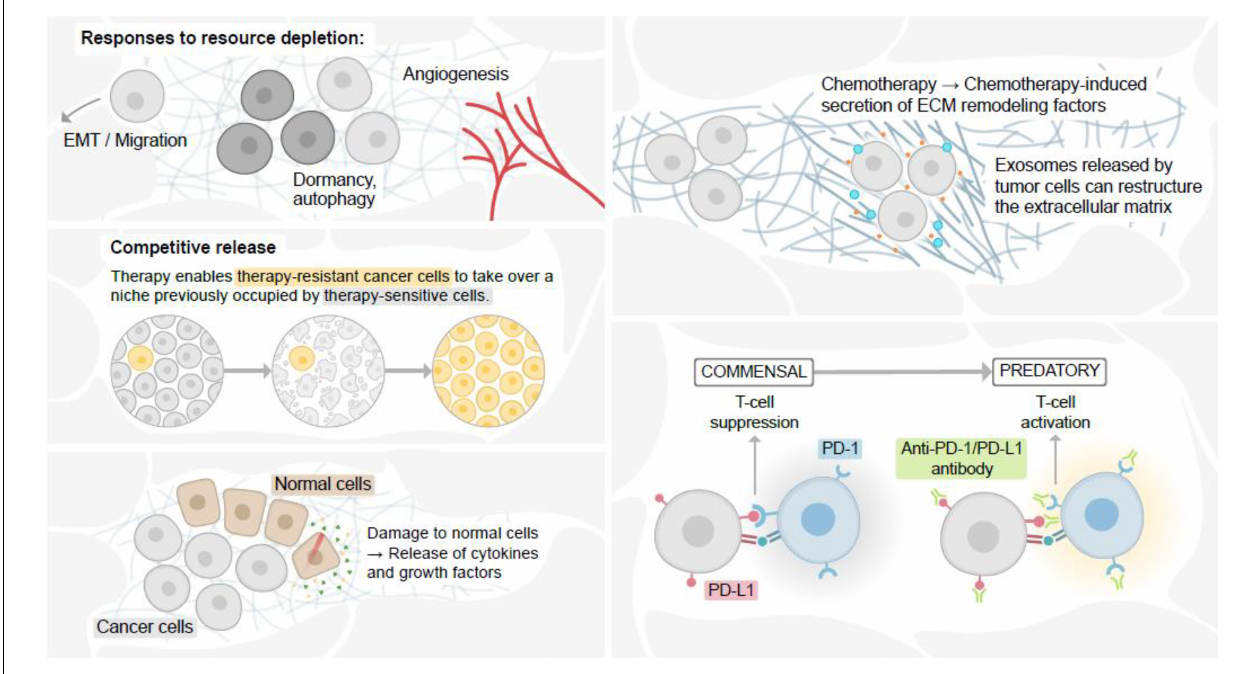
FIGURE 3 | Therapy alters the cancer cell ecological niche. Cellular responses to resource depletion in the face of therapy can induce epithelial-mesenchymal transition (EMT) and migration, altered resource acquisition, and angiogenesis (upper L) . Therapy-induced cellular damage can promote continued growth and tissue remodeling, providing growth factors and tissue space for remaining cancer cells to reoccupy the altered niche (bottom L) . Removal of drug-sensitive cells from an ecological niche can allow drug-resistant cells to take over the new niche (top R) . Immune checkpoint inhibition induces in the immune system a switch from a commensal to predatory.